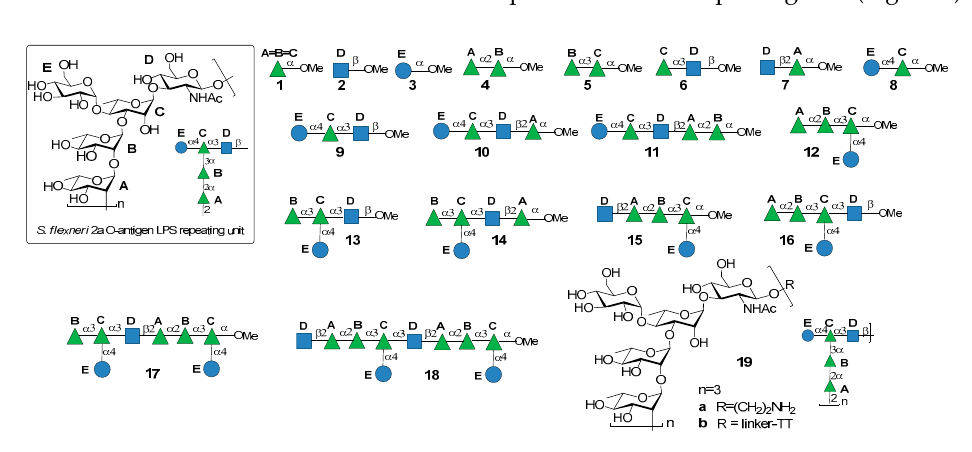
Figure 2. Repeating unit of the O -antigen of S. flexneri 2a LPS and synthetic fragments reported in [16–18]. in